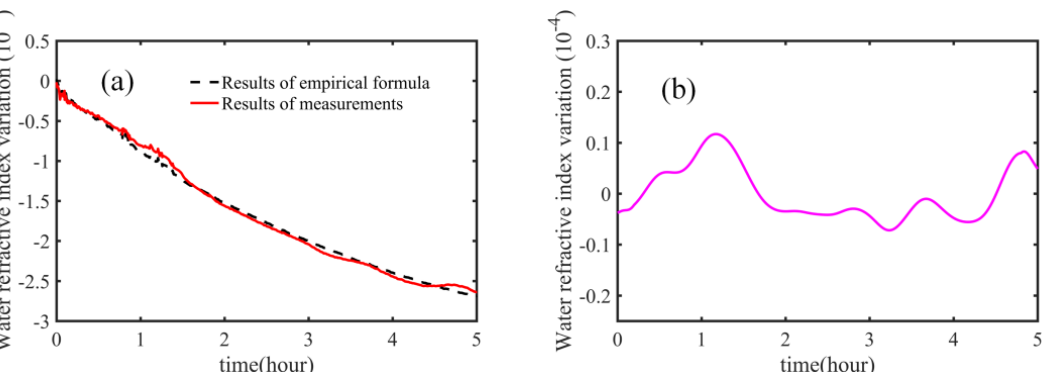
Figure 9. Time measurements of the phase refractive index of water at 518 nm. ( a ) Results of empirical formula and our measurements; red solid line: result of our method; black dashed line: result of the empirical formula; ( b ) difference between the results of empirical formula and our measurements.